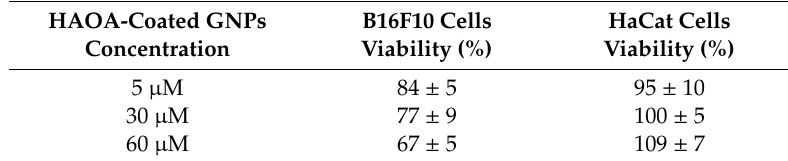
Table 2. In vitro viability of B16F10 and HaCat cells 24 h after incubation with HAOA-coated GNPs (mean value ± S.D., n = 3). HAOA-Coated GNPs B16F10 Cells HaCat Cells Concentration Viability (%)